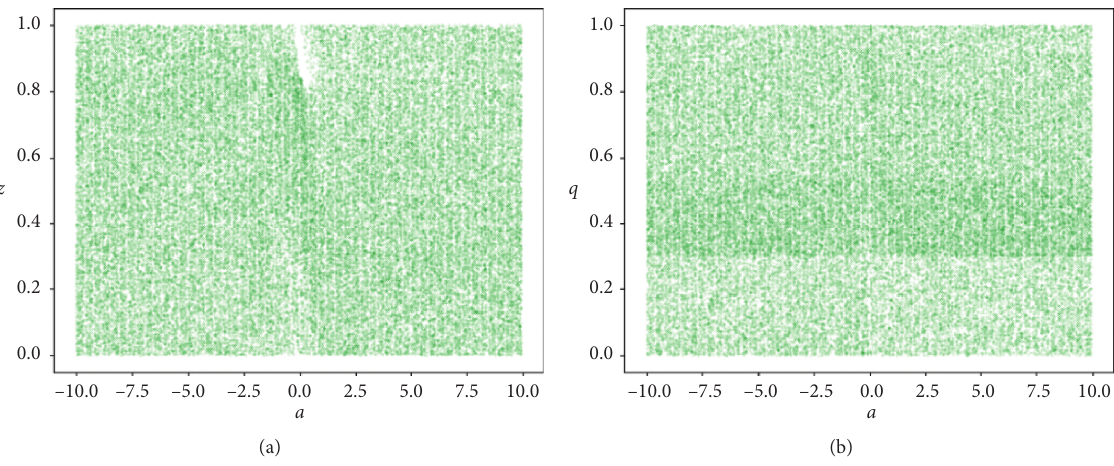
Figure 7: The bifurcation diagram of NHenon. (a) a − z ; (b) a − q .